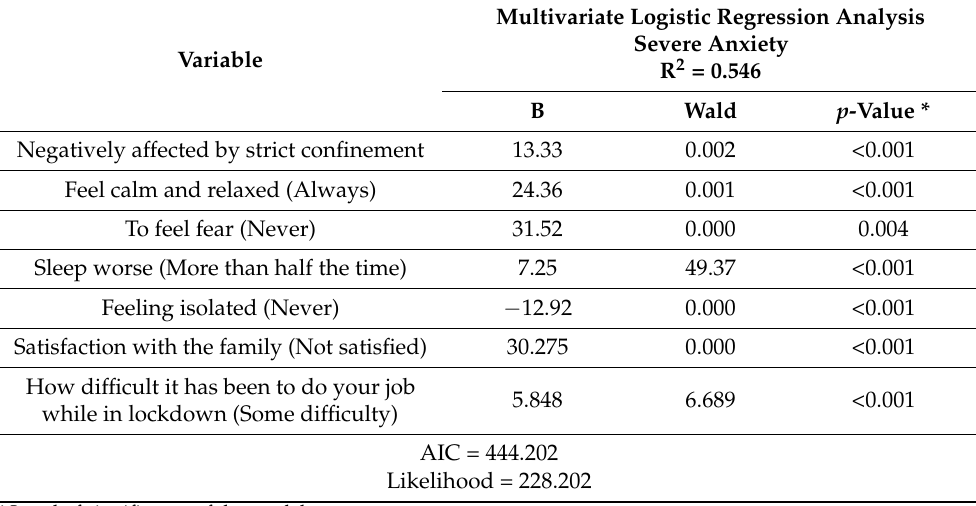
Table 6. Factor associated with moderate to severe anxiety during strict confinement. Multivariate Logistic Regression Variable